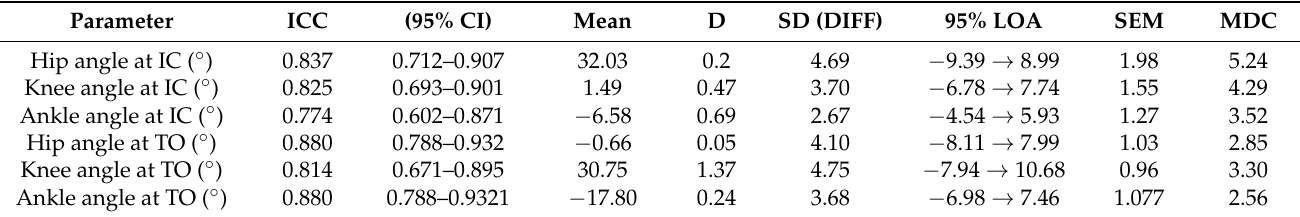
Table 1. Test–retest reliability for kinematic parameters.